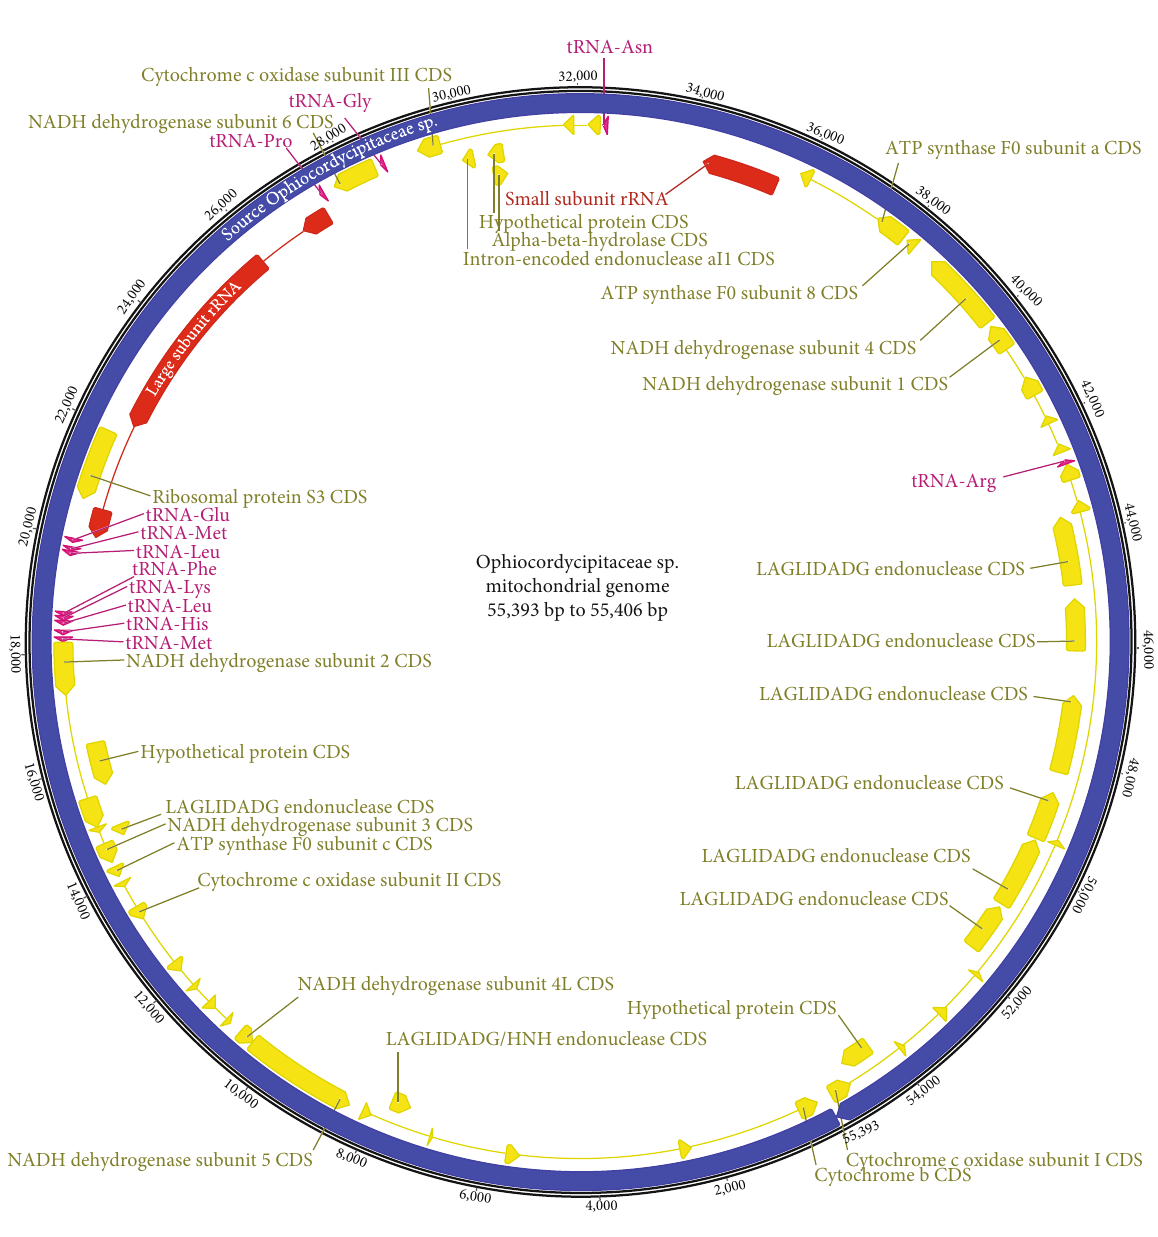
Figure 1: Complete mitogenome of WBPH fungal endosymbionts. Blue circle indicates fungal endosymbiont mitogenome, yellow arrows are protein-coding genes, purple arrows are tRNAs, and red arrows mean rRNAs. Direction of arrows indicates direction of transcription. Each gene name was displayed with lines directing to the corresponded arrows. Numbers displayed outside of blue circle mean base